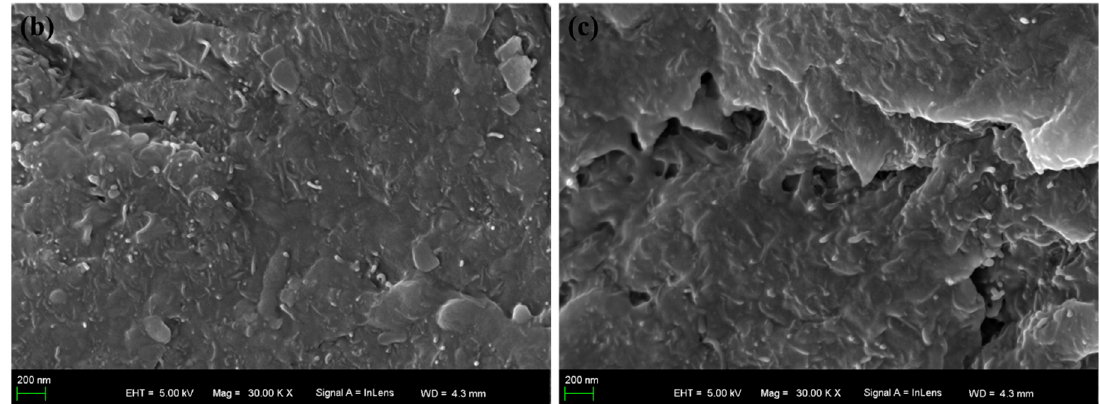
Figure 2. SEM images of ( a ) 0.2 wt % MWCNTs/WPU conductive coating, ( b ) 0.3 wt % MWCNTs/WPU conductive coating, and ( c ) 0.6 wt % MWCNTs/WPU conductive coating.